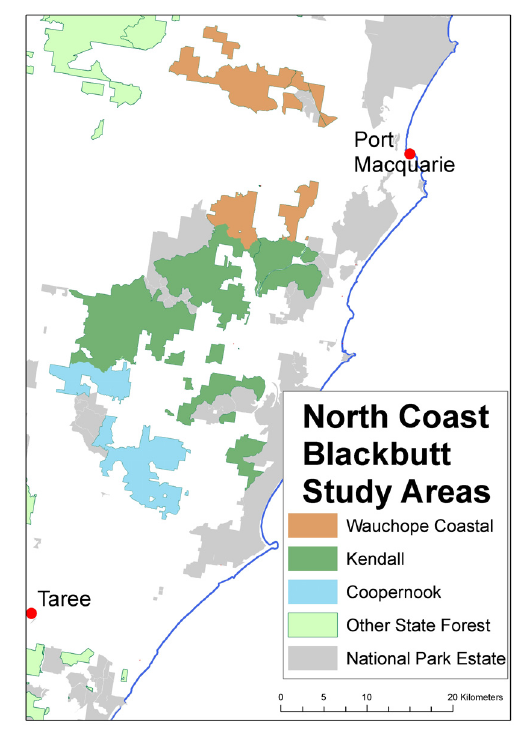
Figure 1. North Coast case study